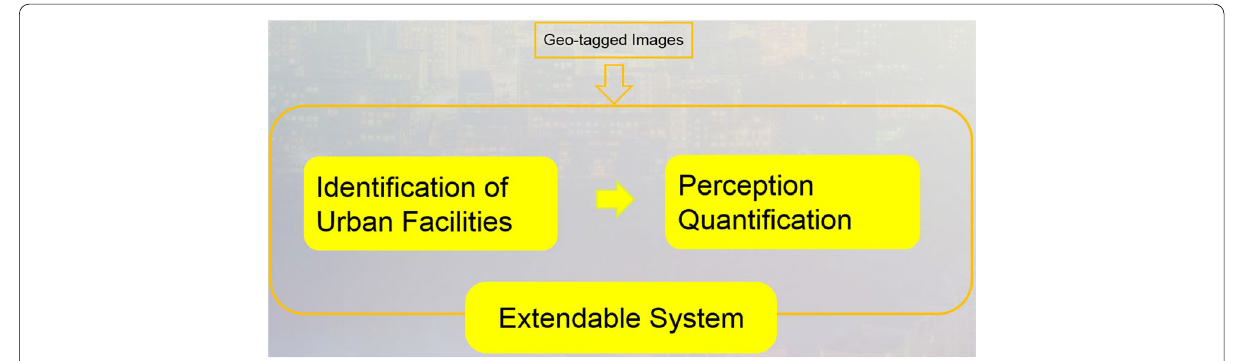
Fig 2 Framework of the assessment process